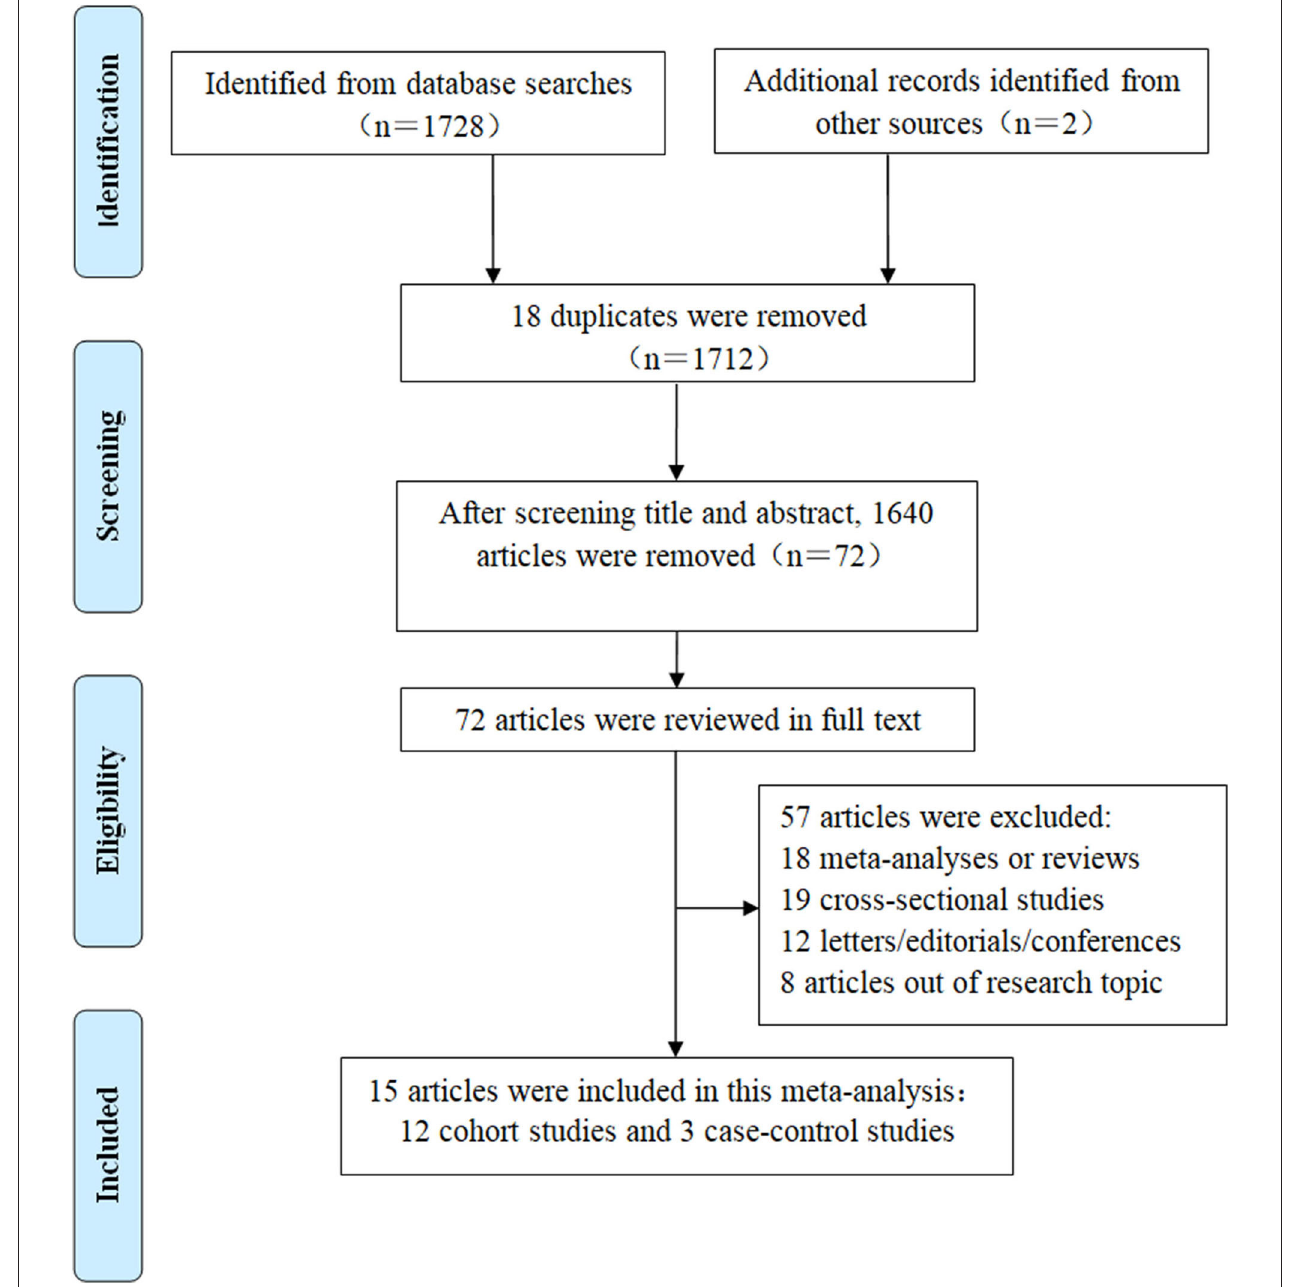
FIGURE 1 | The flow chart for detailed steps of the literature